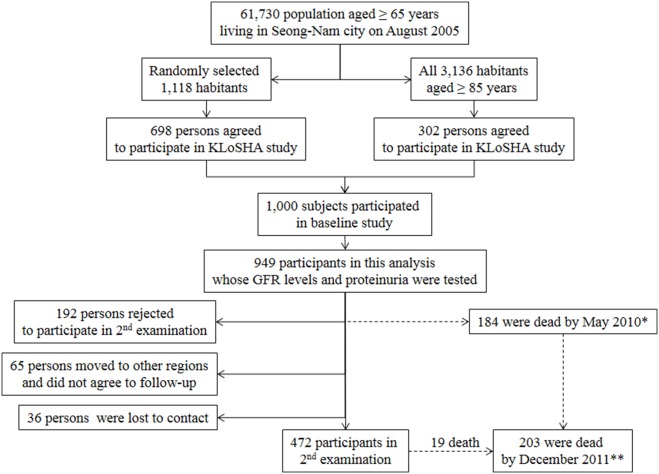
Participants in KLoSHA study.*Mortality was detected by direct contact and the national database. **Mortality was identified by the national database.